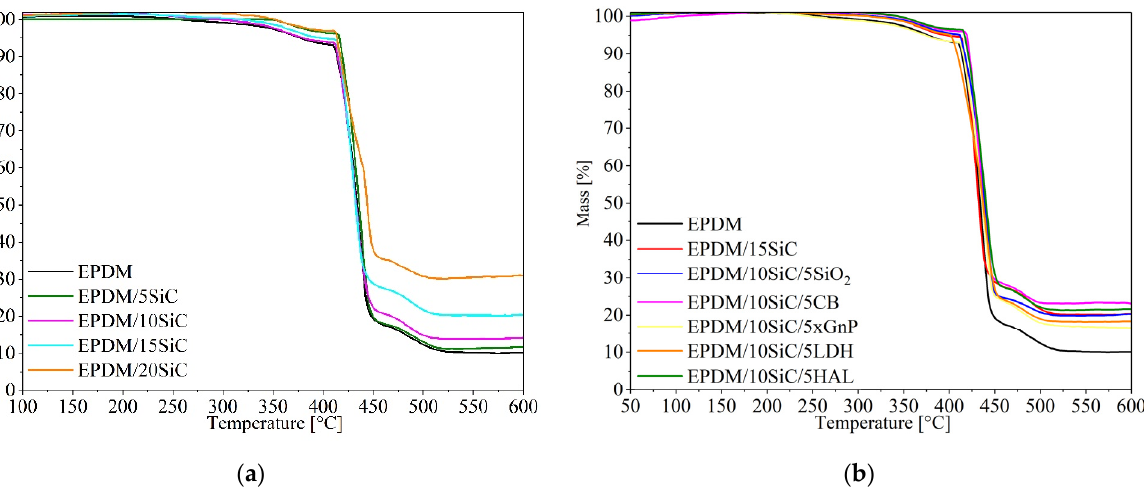
Figure 10. TGA curves for EPDM composites filled with different concentrations of SiC ( a ) and different hybrid filler systems ( b ). Table 6. Thermal stability of EPDM-filled composites.